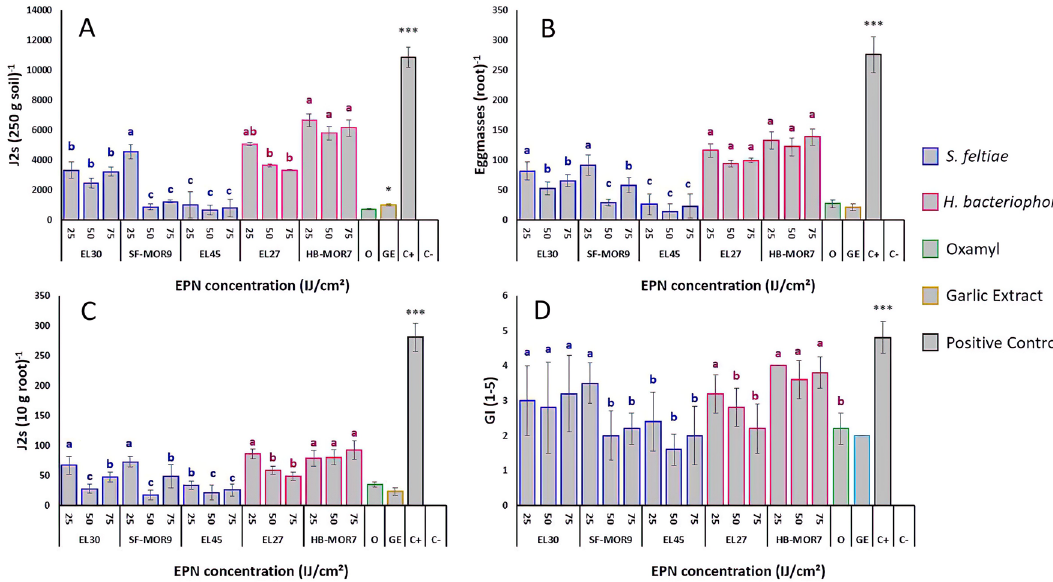
Figure 1. Effect of EPNs ( Steinernema sp., S. feltiae and H. bacteriophora ) against Meloidogyne javanica . ( A ) Number of J2s per 250 g of soil. ( B ) Number of egg masses per root system. ( C ) Number of J2s per 20 g of root. ( D ) M. javanica galling index. Letters represent homogeneous groups based on protected least significant difference test (LSD) for each variable at ( P < 0.05). Error lines on the bars represent the standard